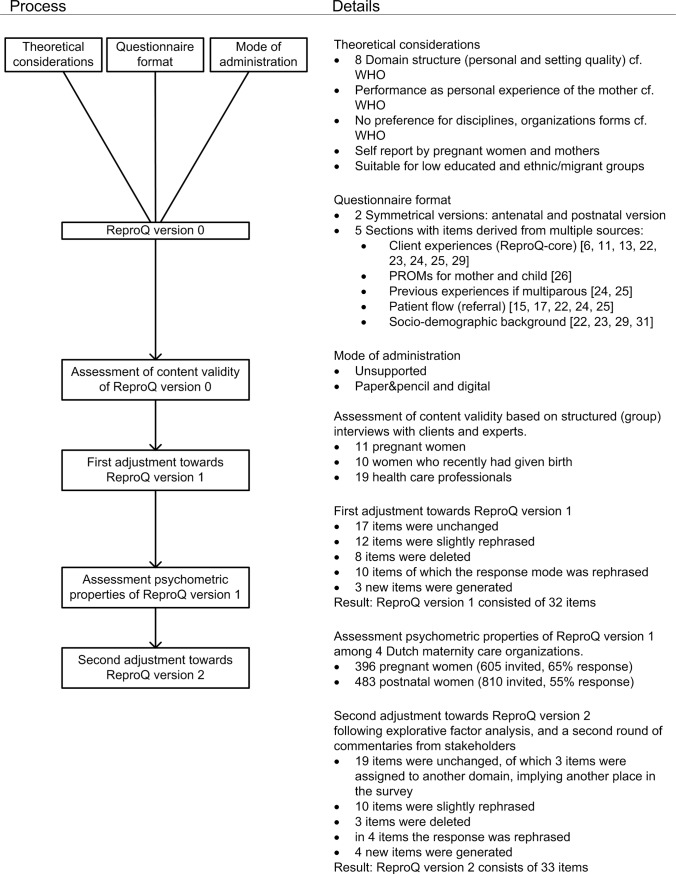
Flowchart of the developmental process of the ReproQ.